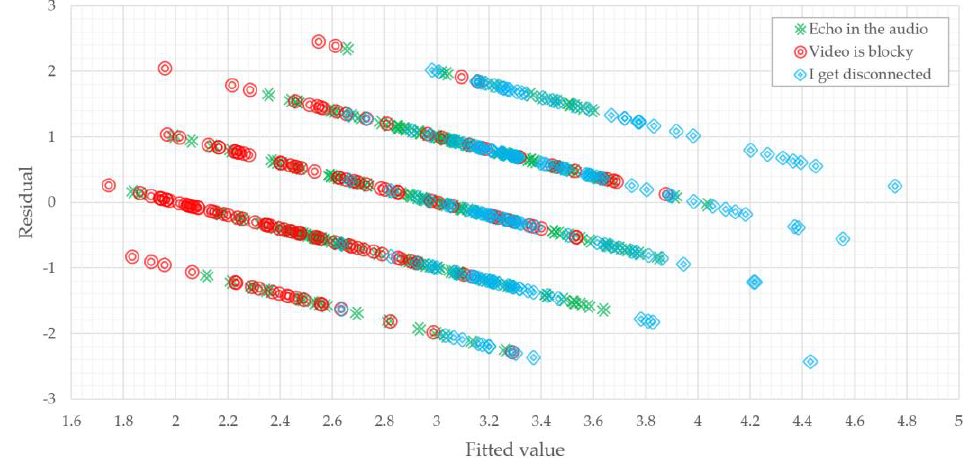
Figure 4. Residual plots for the three quality degradation types.